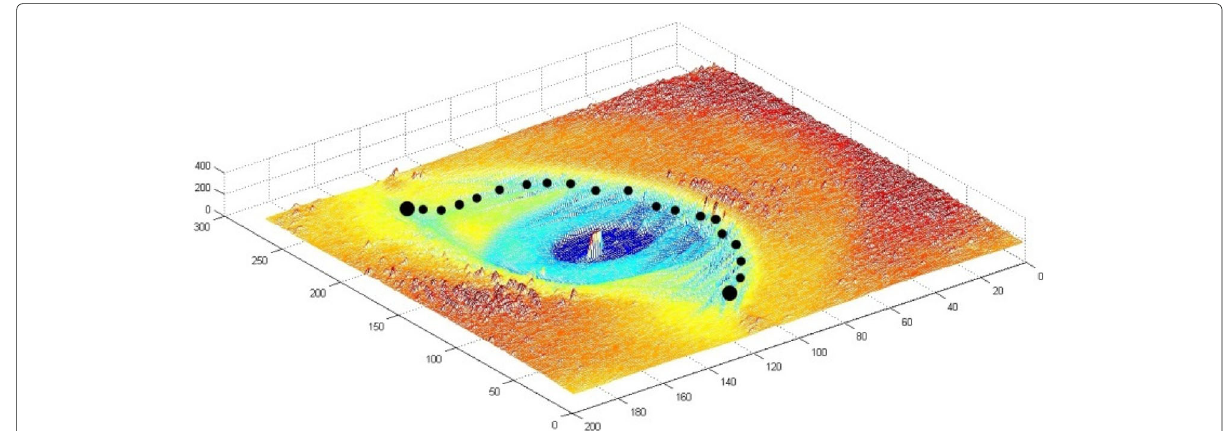
Fig. 4 The example of rough detection of eye corners and upper edge of the